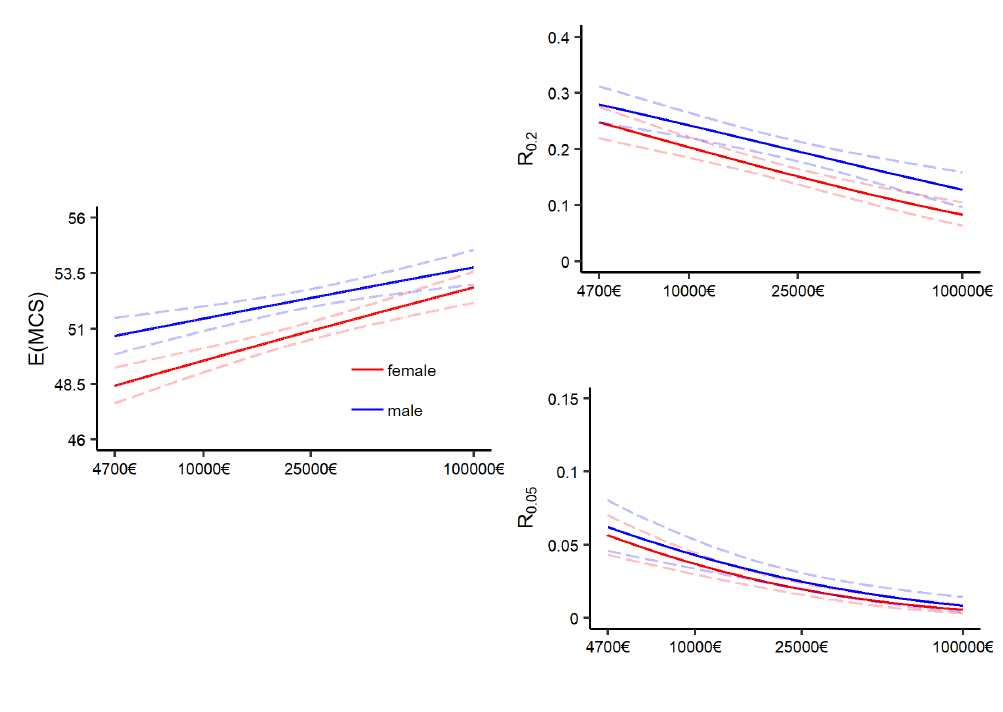
Figure 3. Effect of income on distribution measures for the GA model: Ga ( µ = (cid:88) , σ = (cid:88) ). Left : Effect of income on the expectation. Right : Effect of income on risk of falling below the lowest quintile and lowest vingtile.